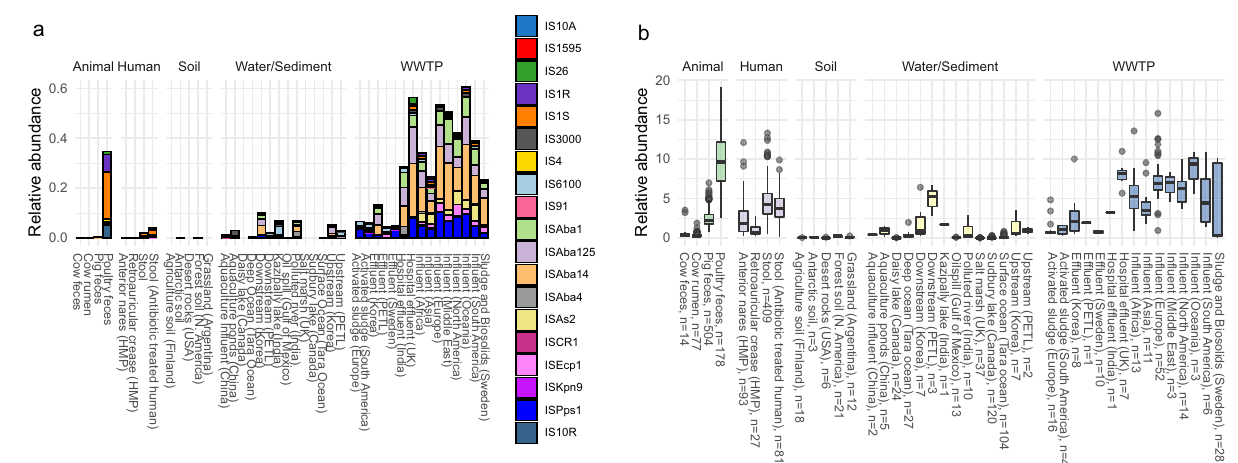
Fig. 3 Relative abundance of IS elements. The average relative abundance of speci fi c IS elements likely to have been involved in the mobilization of an antibiotic resistance gene (MISE) ( a ) and relative abundance of all IS elements ( b ). Boxplot: A box represents the fi rst (Q1) and third (Q3) quartile (the 25 – 75th percentile), the centerline represents the median. The dots represent values larger or smaller than Q1 − 1.5 or Q3 + 1.5 times the inter- quartile